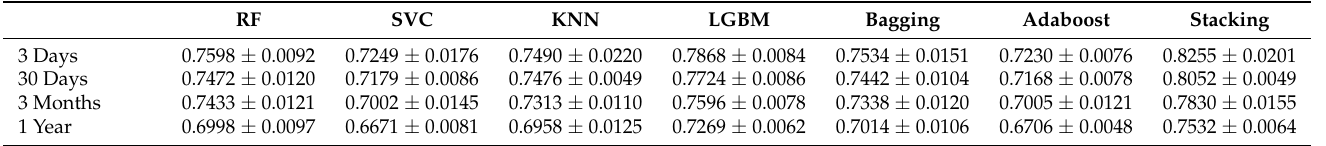
Table 4. The AUROCs of different classifiers.